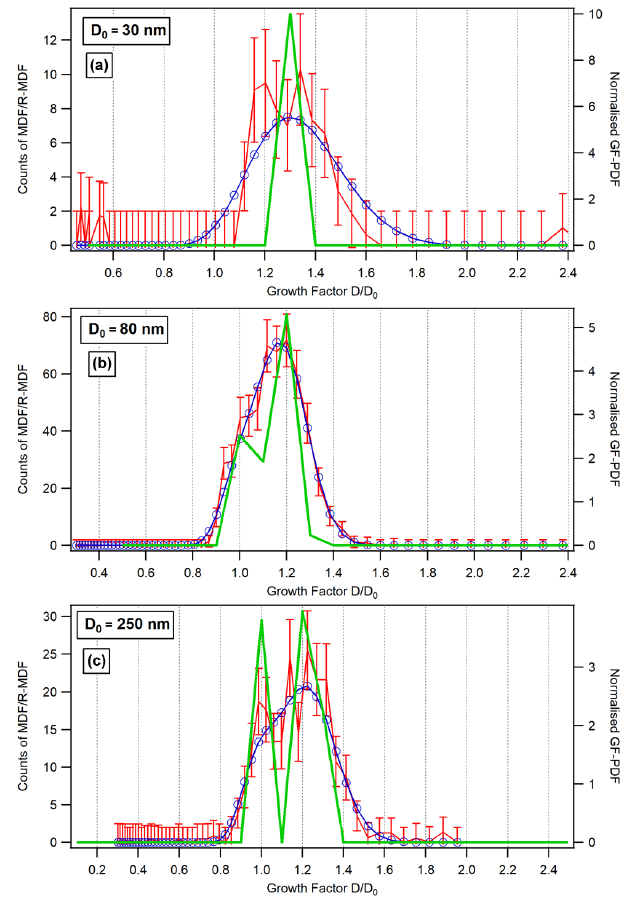
Figure 3. Example of growth factor distributions measured at RH = 90% of D 0 = 30nm particles ( a , internally mixed), of D 0 = 80nm particles ( b , continuum of mixing states) and of D 0 = 250nm particles ( c , externally mixed with distinct modes). The red line represents the measured particle counts, the blue line represents the reconstructed measured distribution function, and the green line is the